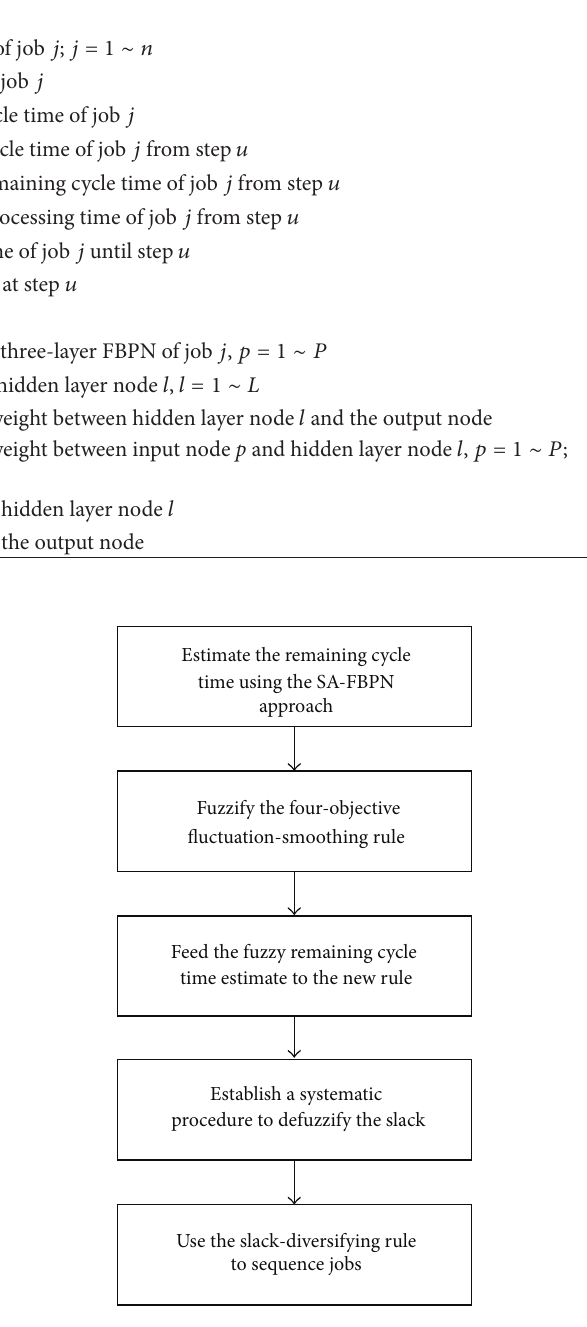
Figure 1: The flowchart of the proposed